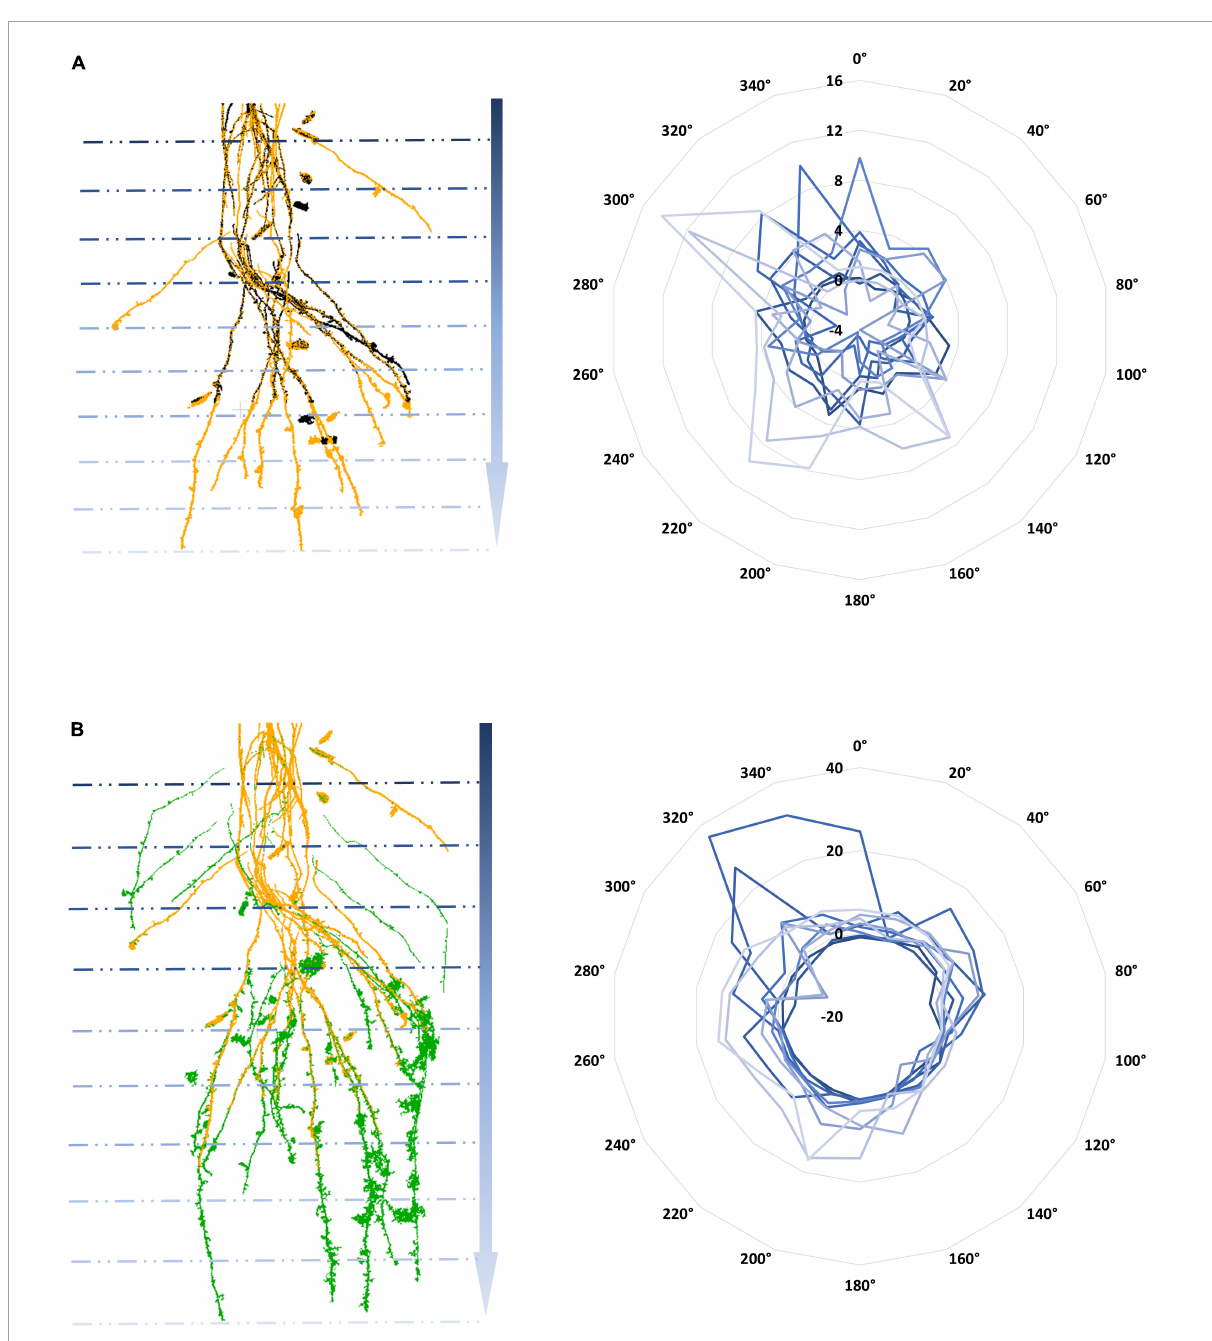
FIGURE6 Temporal computed tomography (CT) scans overlap with a weekly time lapse: weeks 1 and 2 (A) and weeks 2 and 3 (B) in different colors on the left with its subsequent growth defined by the spread’s variations [computed by using an scale factor (SF) of 0.1] at 10 depths and 18 directions radially represented in blue scale color on the